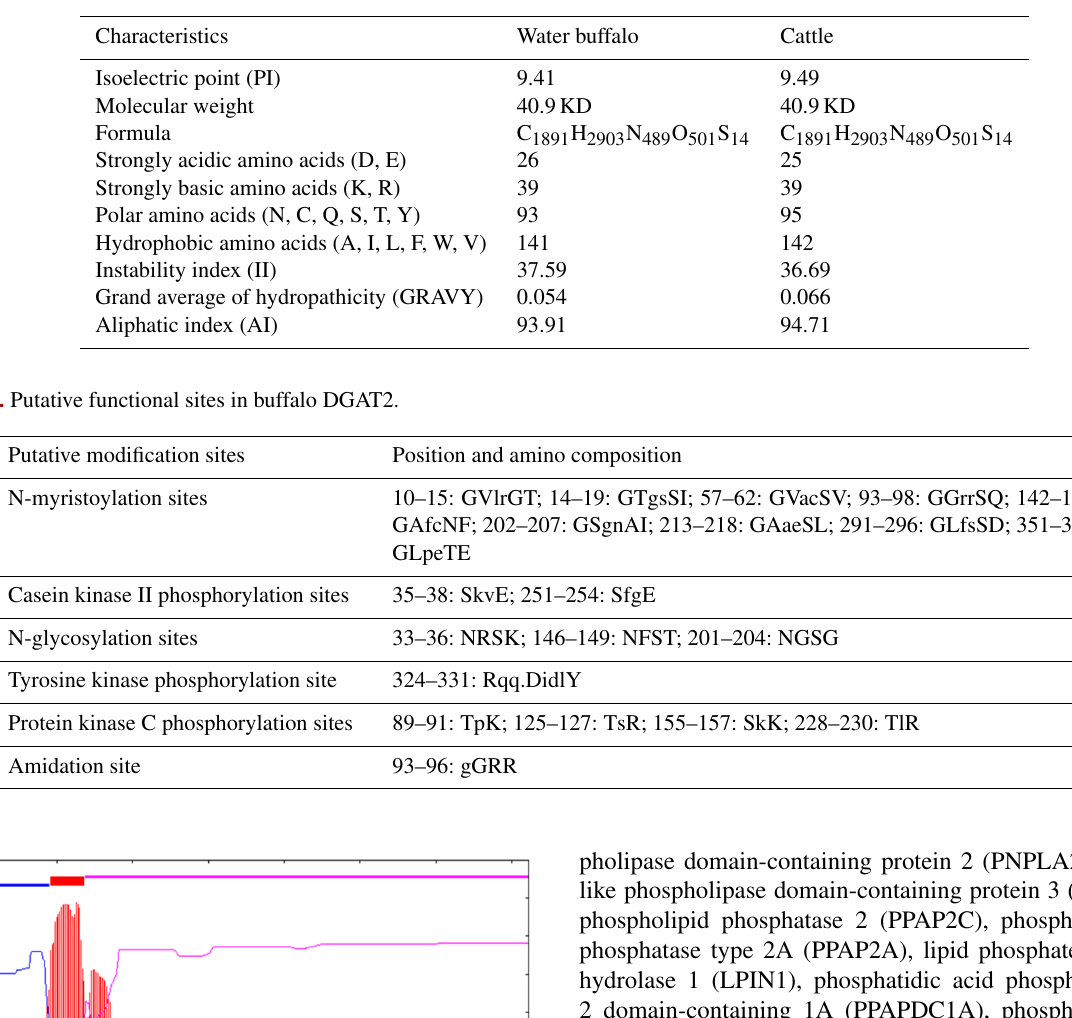
Table 2. Basic characteristics of DGAT2 for buffalo and cattle.